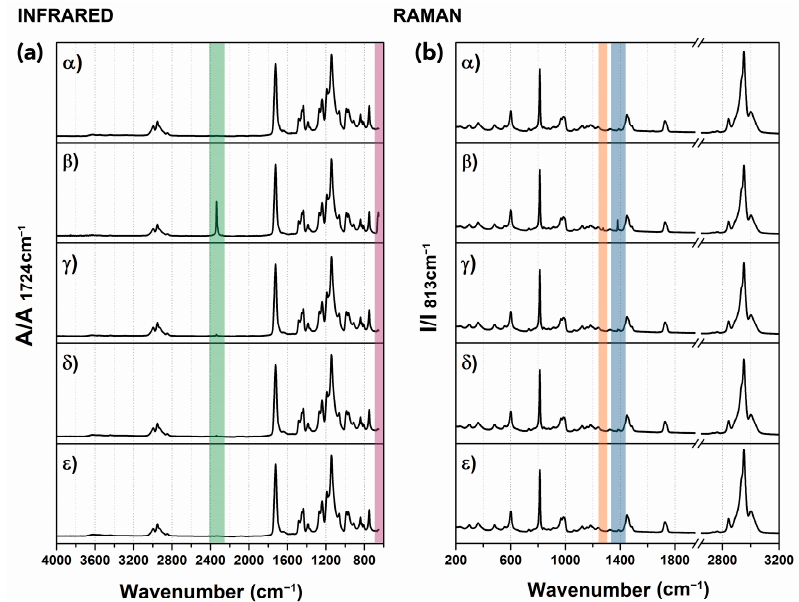
Figure 9. ATR-FTIR and Raman spectra for a sample exposed to scCO 2 at 35 °C and 10 MPa ( α ) before the test ( β ), 2 h after the test ( γ ), 5 days after the test ( δ ), 1 week after the test ( ε ), and 35 weeks after the test. The colored rectangles in the infrared graph highlight the CO 2 absorption bands at approximately 2338 cm − 1 (highlighted in green) and at 662 and 654 cm − 1 (highlighted in violet), while the orange and blue rectangles in the Raman spectra highlight the peaks at 1391 and 1286 cm − 1 , respectively. All peaks are attributed to the CO 2 in the gas phase and dissolved in PMMA. CO 2 peaks disappeared 5 days after exposure.